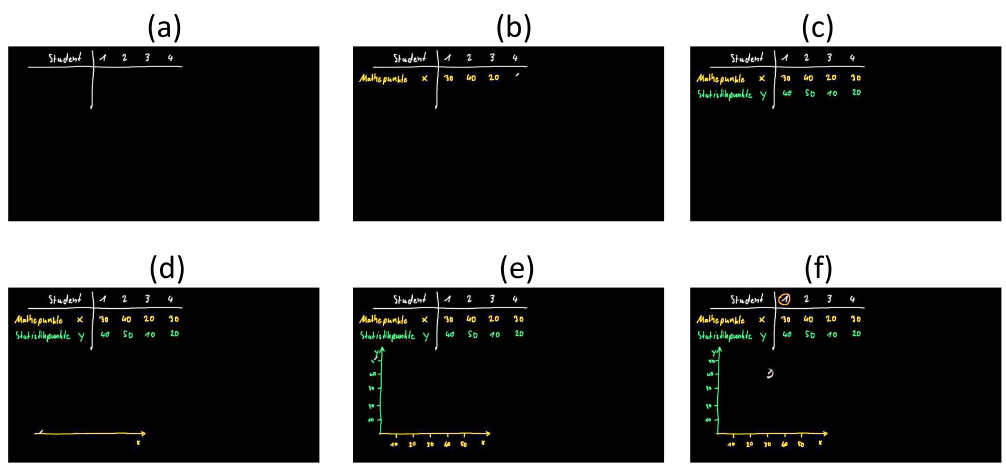
Figure 1. Screen shots of the visual development of Video 1 (00:00–03:00) showing six snapshots ( a – e ) as the explanation